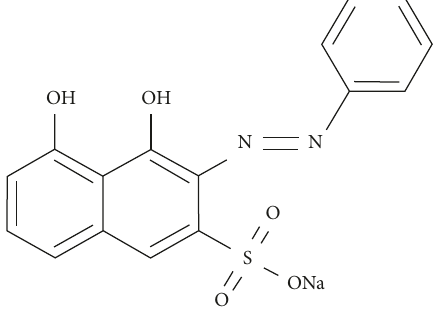
Figure 1: Chemical structure of